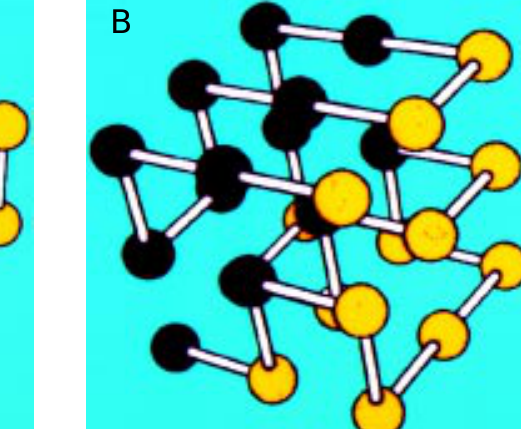
Figure 3 - Lattice models. A , Square; B ,